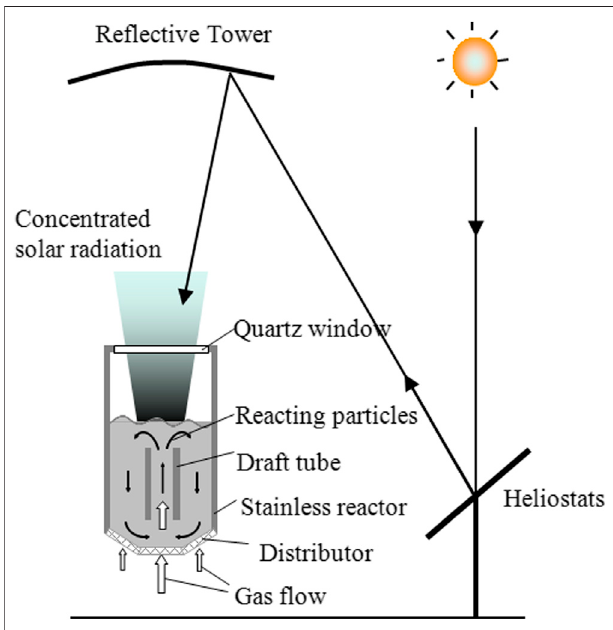
FIGURE 5 | The schematic ofthe internally circulating fl uidized bed solar receiver/reactor (reprinted from Kodama et al. (2017b), with the permission of AIP Publishing).